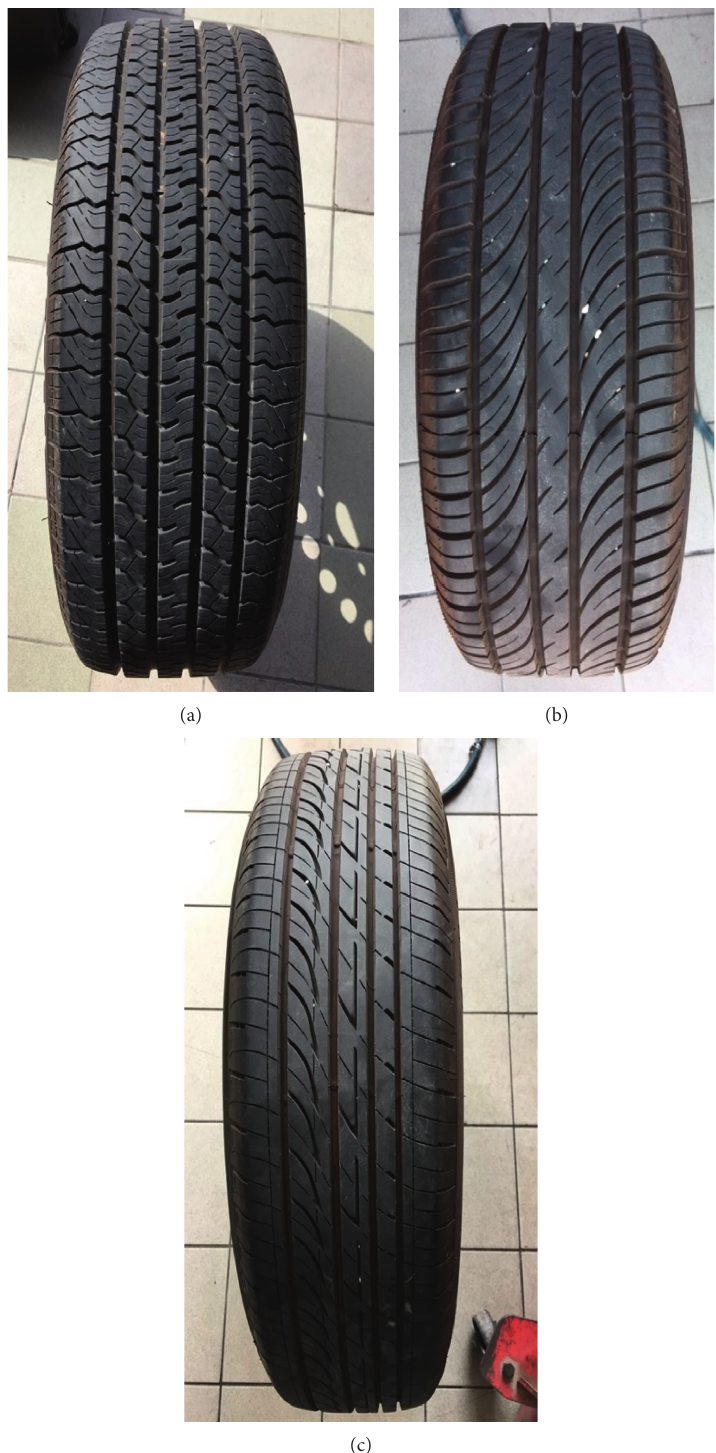
Figure 10: Types of tires used in the study. (a) Standard reference test tire. (b) Oniza. (c)